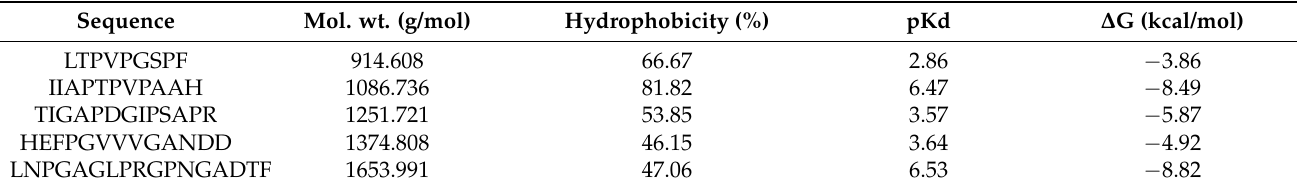
Table 1. The binding efficiency parameters of the de novo sequenced peptides to t -ACE.